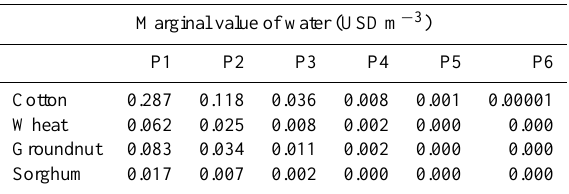
Table 3. Marginal values of water for each